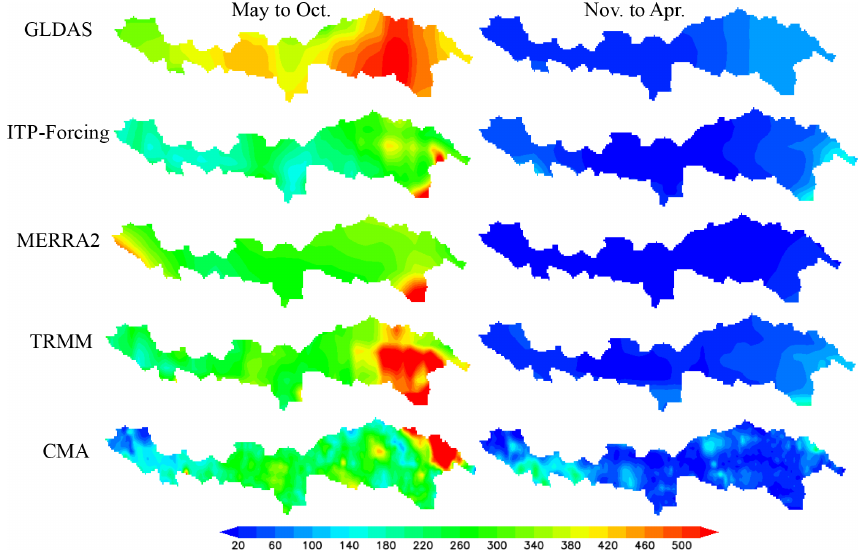
Figure 4. The spatial distribution of different precipitation products during the warm season (May to October) and the cold season (November to April) averaged from 2008 to